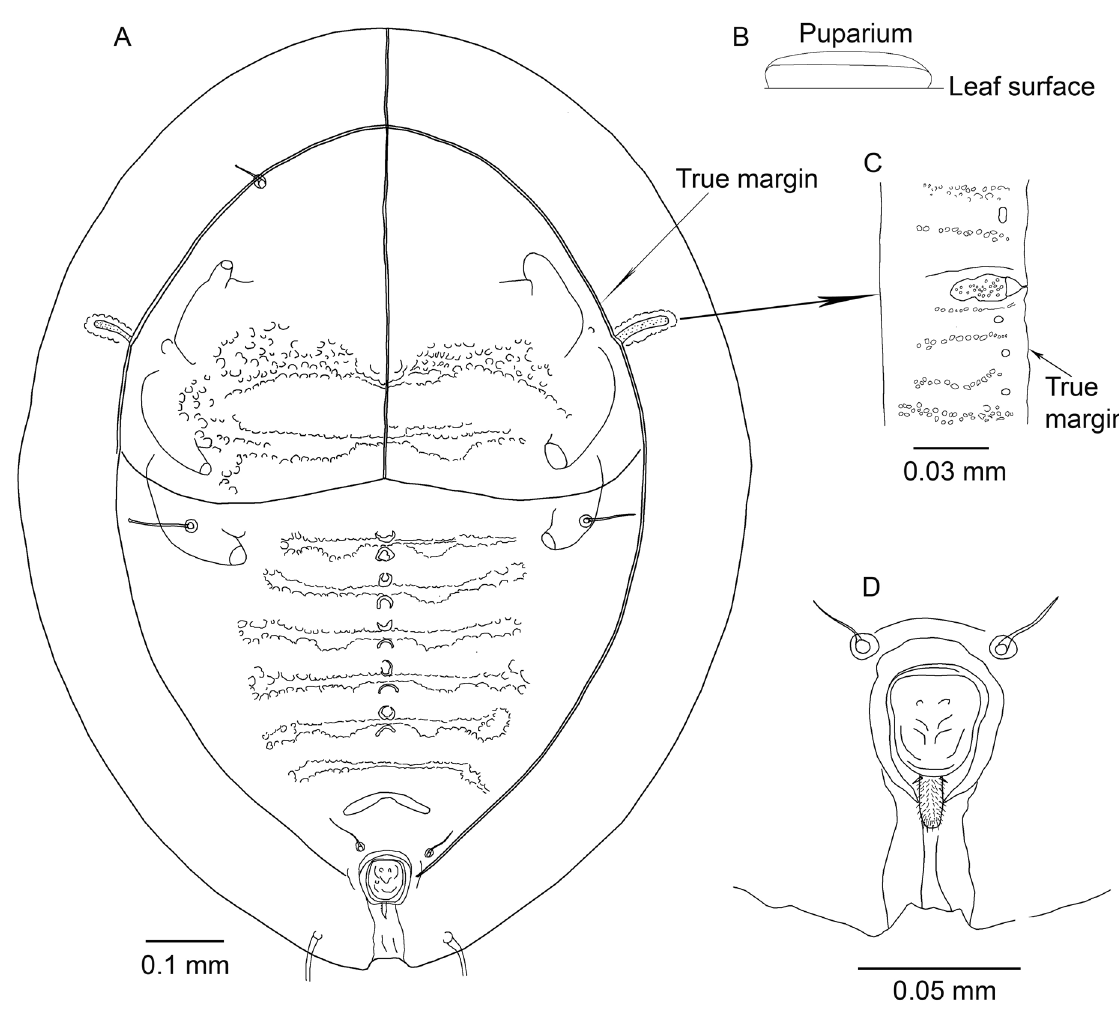
Fig. 3. Rudisculptus caudalis gen. et sp. nov., ♀, holotype (ANRC-ZSI), line drawings. A . Dorsal and ventral views. B . Diagrammatic presentation of puparium on leaf in lateral view. C . Thoracic tracheal pore. D . Vasiform